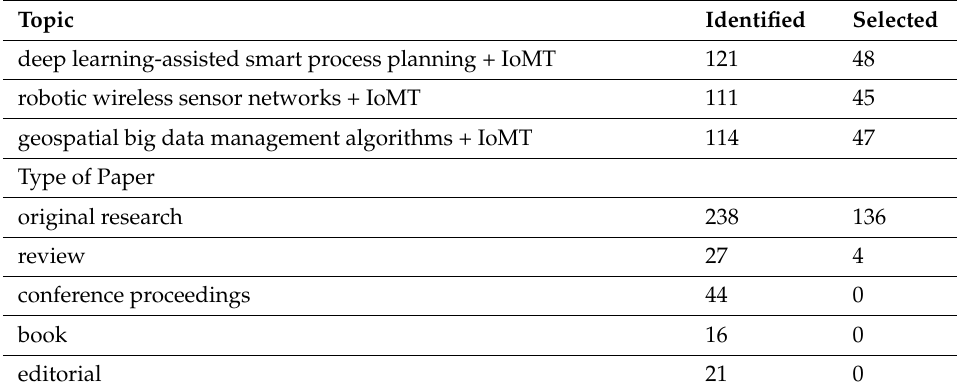
Table 1. Topics and types of paper identified and selected.